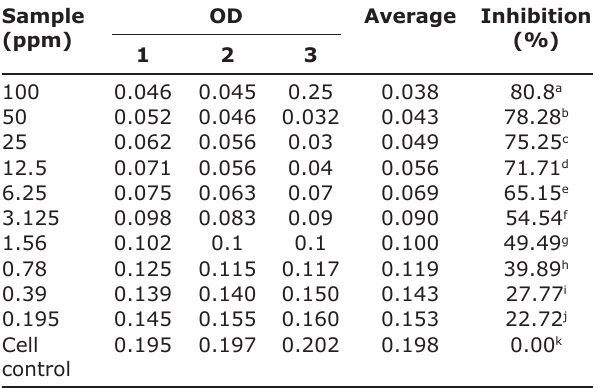
Table-3: Toxic isolate (FB) inhibition. Sample (ppm)